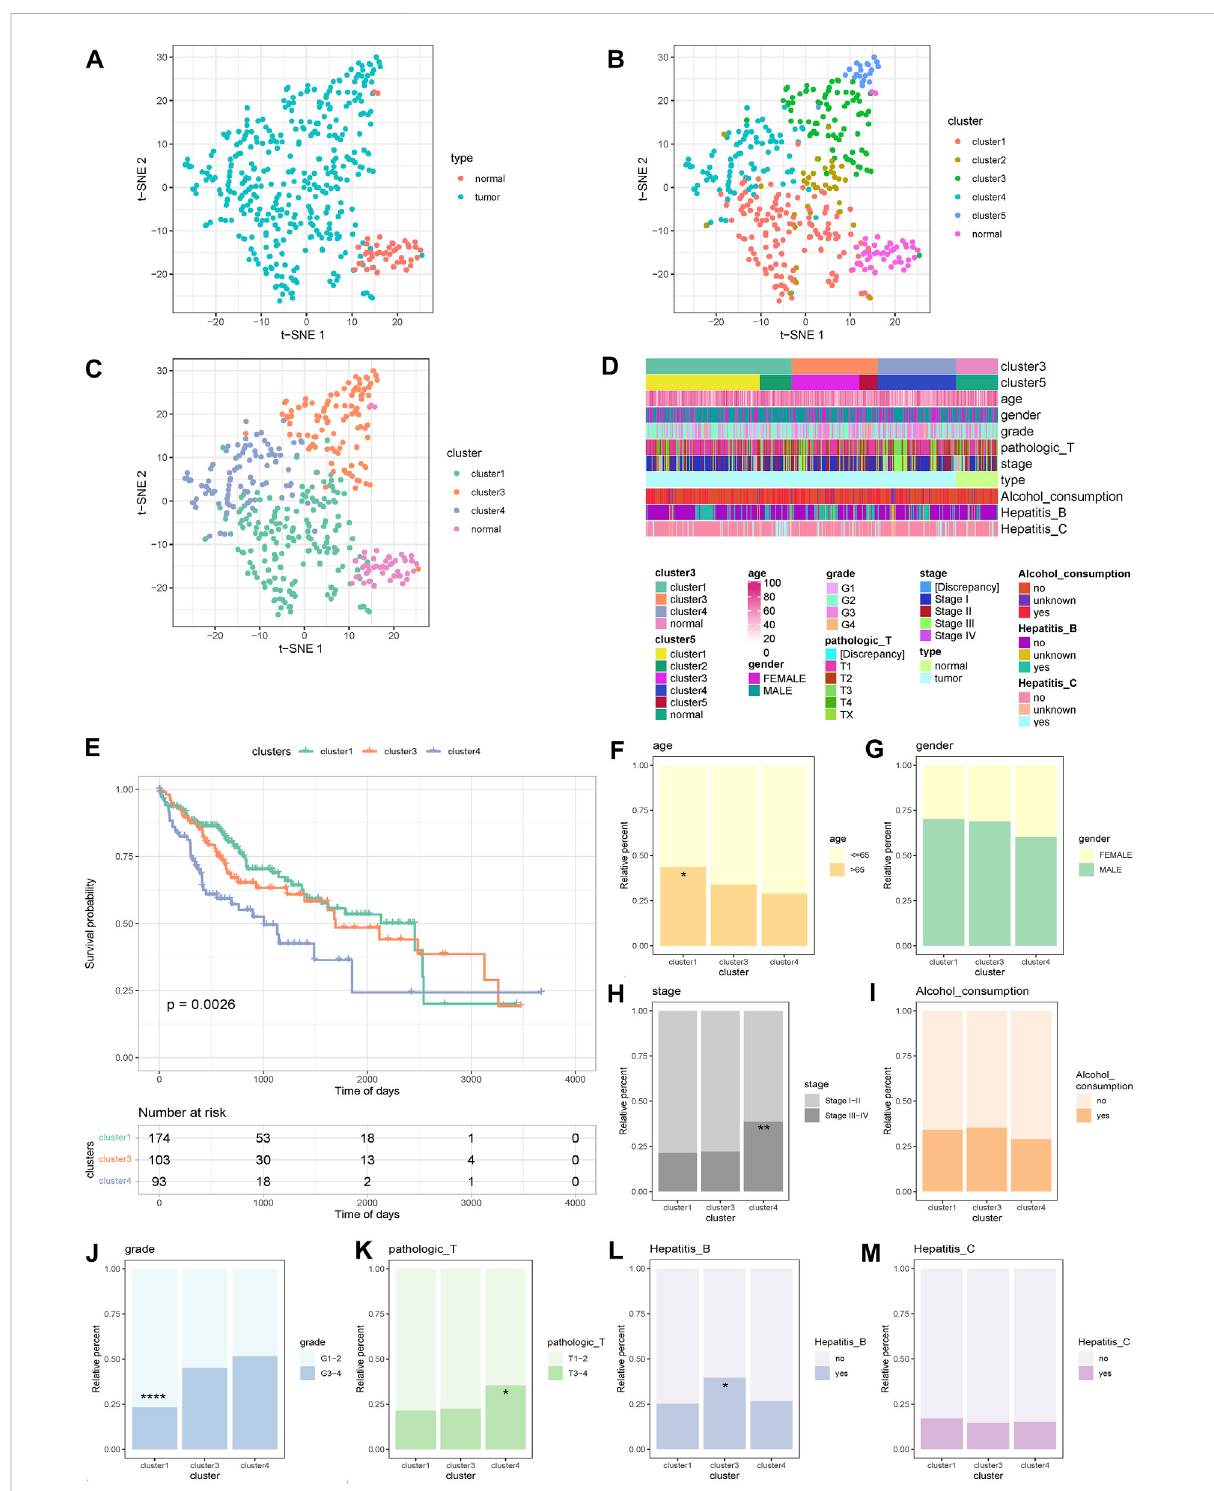
FIGURE 1 Sample cluster display and survival differences and clinical analysis. (A) Cluster scatter plot display of cancer samples and normal samples. (B) Unsupervised clustering scatter plot display of cancer samples in 5 categories. (C) Scatter plot display of 5 categories of samples merged into 3 categories. (D) Clustering Heat map display of samples and clinical traits. (E) KM curves of 3 alternative splicing subtypes. (F – M) Display of clinical features and distribution of typical types. **** p < 0.0001; *** p < 0.001; ** p < 0.01; * p <